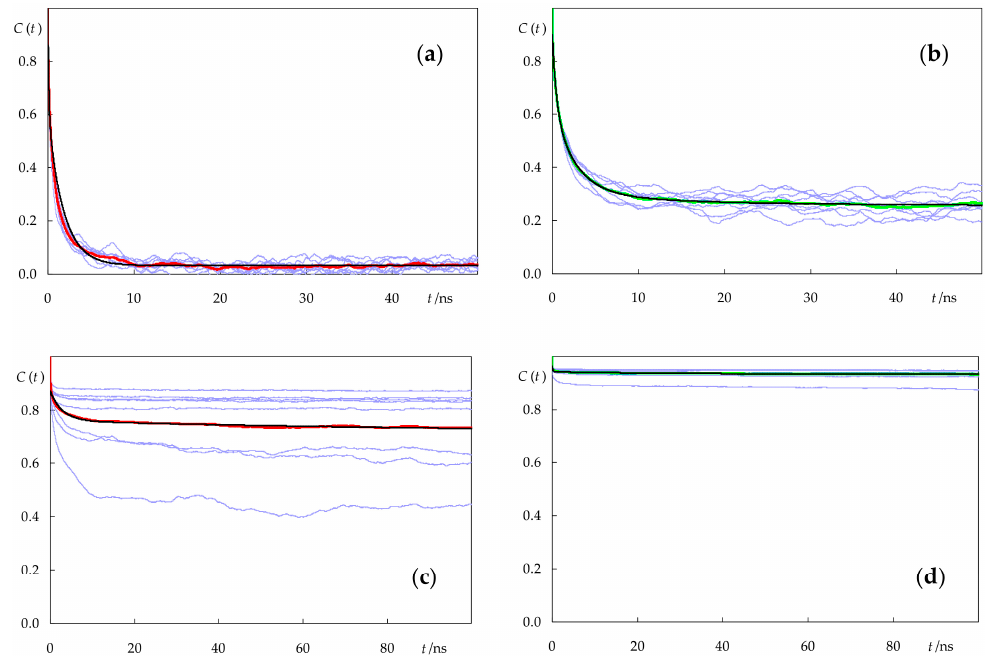
Figure 10. Rotational ACFs C ( t ) of c ‐ PnA ( a , c ) and t ‐ PnA ( b , d ) in POPC ( a , b ) and DPPC ( c , d ). Each thin blue line represents the C ( t ) of an individual fluorophore. The red and green lines (for c ‐ PnA and t ‐ PnA, respectively) represent the average over the eight simulated molecules of each probe in a given system. The black lines are fits to multiexponential functions (Equation (2); see Table 1 for best fit parameters). Table 1. Best fit parameters of Equation (2) to the calculated rotational ACFs.